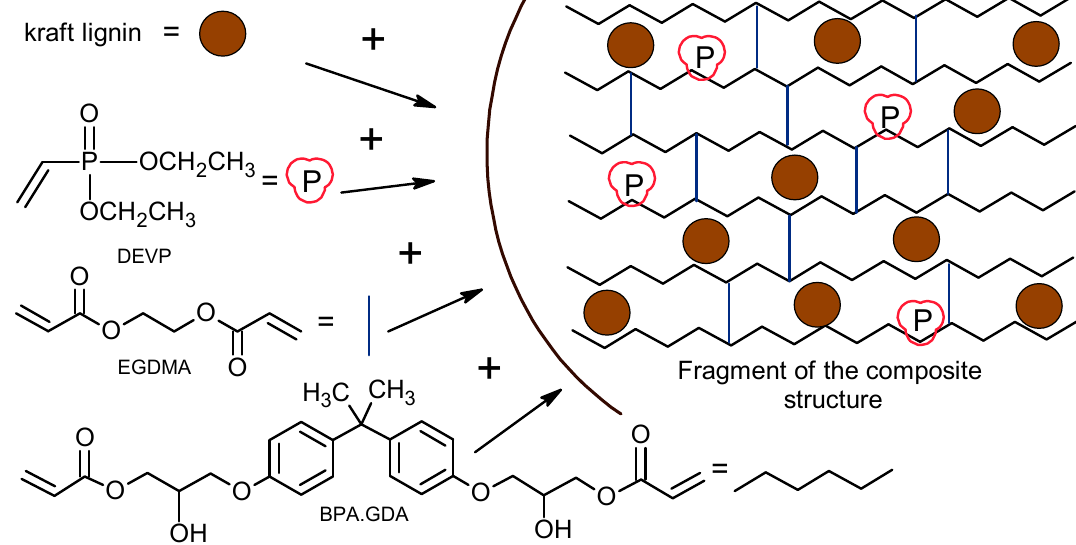
Figure 16. Chemical structure of monomers and the exemplary fragment of composites structure.